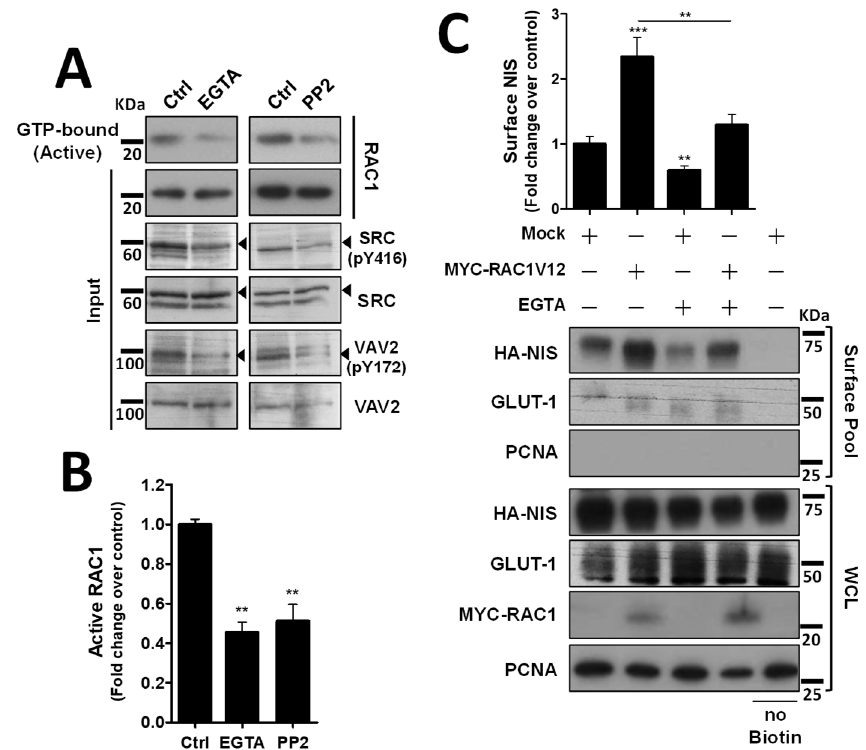
Figure 4. Both AJ integrity and SRC activity impact endogenous RAC1 activation. ( A ) The impact of EGTA-mediated AJ displacement or SRC kinase inhibition on endogenous RAC1 activation status in HA-NIS-TCP1 cells was assessed by monitoring the active, GTP-bound fraction of RAC1 by CRIB domain pull-down assay. Both total (input) and active RAC1 levels were assessed by WB using anti-RAC1 primary antibody. SRC autophosphorylation (using anti-SRC-pY416 antibody) and in SRC activating phosphorylation of VAV2 (using anti-VAV2-pY172 antibody) were also monitored in the same conditions by WB. ( B ) GTP-bound fraction of RAC1 was quantified by densitometry analysis of WB bands, using ImageJ software. Plotted values are means ± SEM of three independent assays. A two-tailed Student’s t -test was used to identify significant variations relative to the control (** p ≤ 0.01). ( C ) PM-NIS levels were analyzed by surface protein biotinylation in HA-NIS-TPC1 cells treated with EGTA (as in ( A )) or transfected with either an empty vector (Empty) or GFP-RAC1-V12. Both surface fraction and correspondent whole-cell lysates (WCL) were analyzed by WB, as indicated. A replica where cells treated as in ‘Ctrl’ were not incubated with biotin (no Biotin) controlled the specificity of biotinylated protein pull-down. GLUT-1 served as loading control (for densitometric normalization) among cell-surface protein extracts and WCL, whereas PCNA monitored for both WCL loading and eventual intracellular protein contamination in cell-surface extracts. The WB bands were quantified as in ( B ) and plotted as the means ± SEM of at least four independent assays. Significant differences between treatments were detected using one-way ANOVA analysis (F = 18.09; p < 0.001). Significant variations from control conditions (Ctrl) were identified using post hoc Dunnett’s tests identity (** p ≤ 0.01; *** p ≤ 0.001). The uncropped bolts are shown in Supplementary Materials File